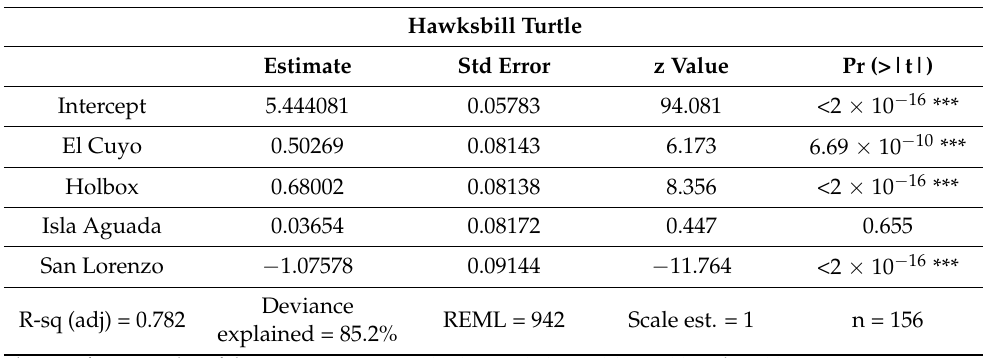
Table 2. Results of the generalized additive models to evaluate the temporal effects of the nesting season on the number of nests of hawksbill ( Eretmochelys imbricata ) sea turtles at five nesting beaches in the Gulf of Mexico. Lechuguillas was excluded from the analysis due to its small sample size, and Cayos Arcas is not a Hawksbill nesting site.